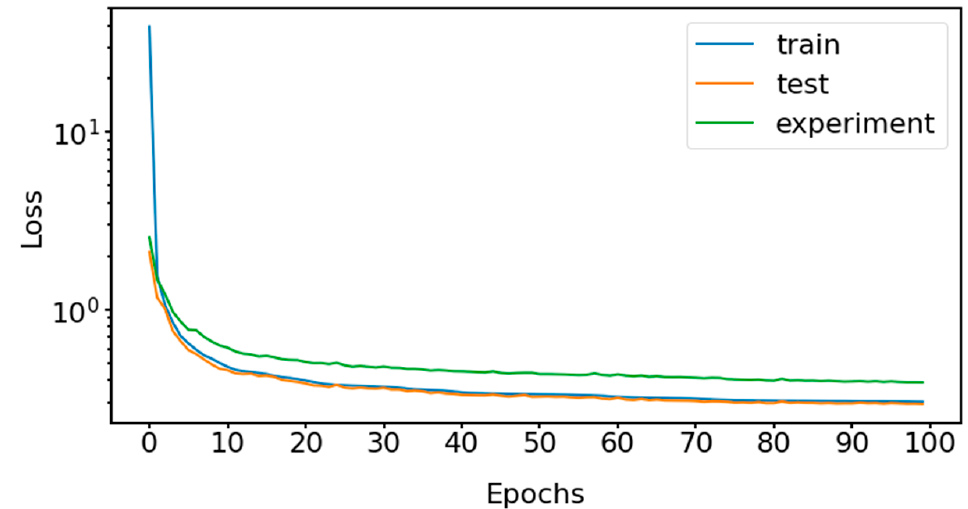
Figure 7. An example of the loss function optimization for GCAEC model trained for 100 epochs on the mixed dataset of samples generated by sliding a 50-s sampling window. First, we conducted an experiment where we trained our GCAEC model on simulated and mixed datasets with different sampling window sizes. As shown in Table 1, increasing the window size yields better classification performance. For all window sizes, the most common misclassification was between the healthy state and the misconfigured safety valve state. Table 1. Average precision and recall for the classification of 4 states by our GCAEC model.